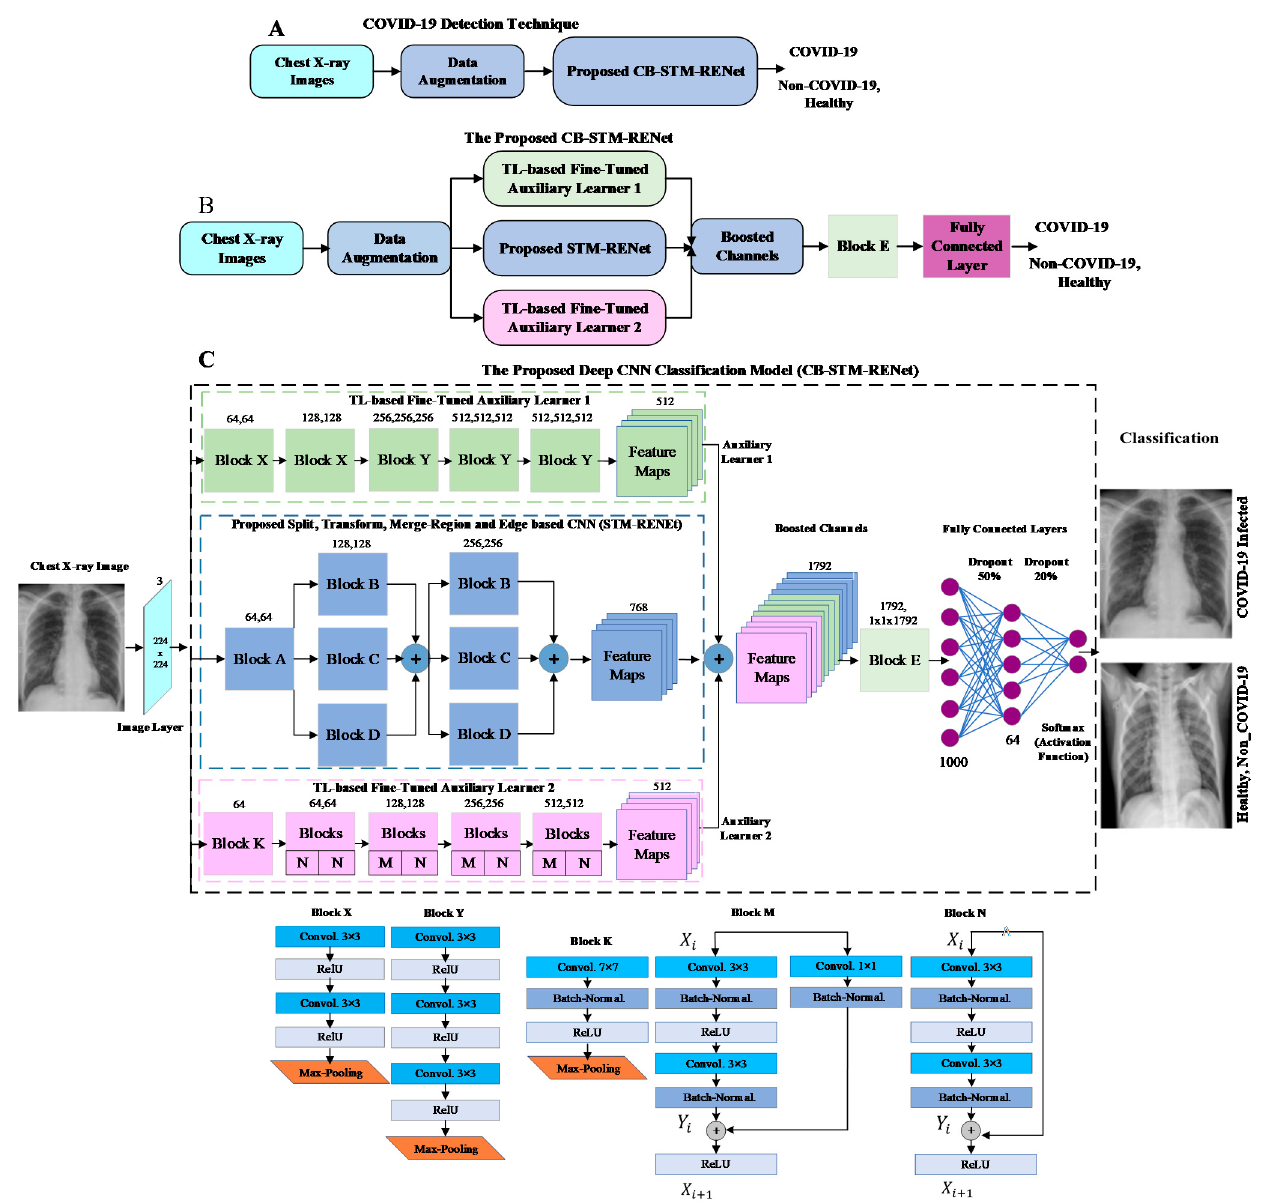
Figure 4. Panel ( A – C ) illustrate the brief and detailed proposed CB-STM-RENet COVID-19 detection technique, respectively.